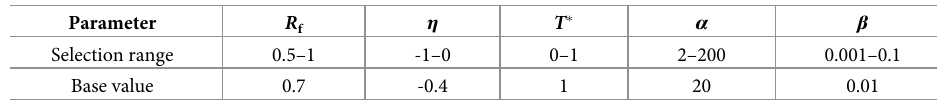
Table 3. Range of model